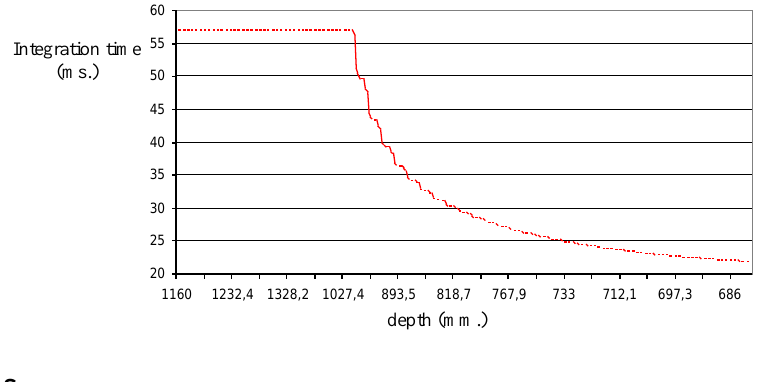
Figure 18. Integration time values at each iteration of the visual servoing task. Experiment